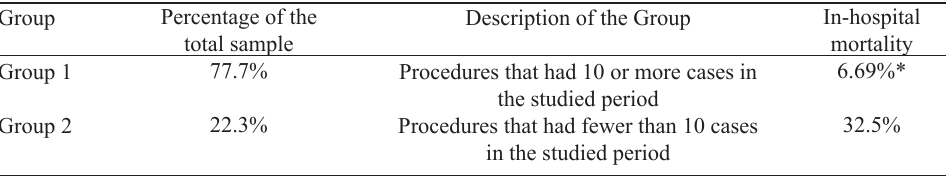
Table 3. In-hospital mortality according to the 2